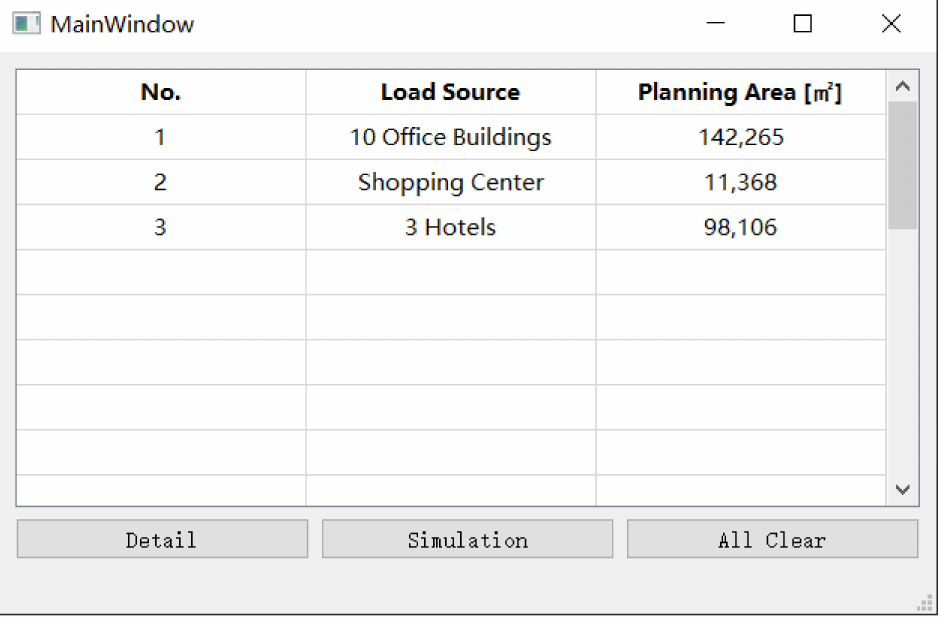
Figure 18. Main UI of the fast estimate tool.